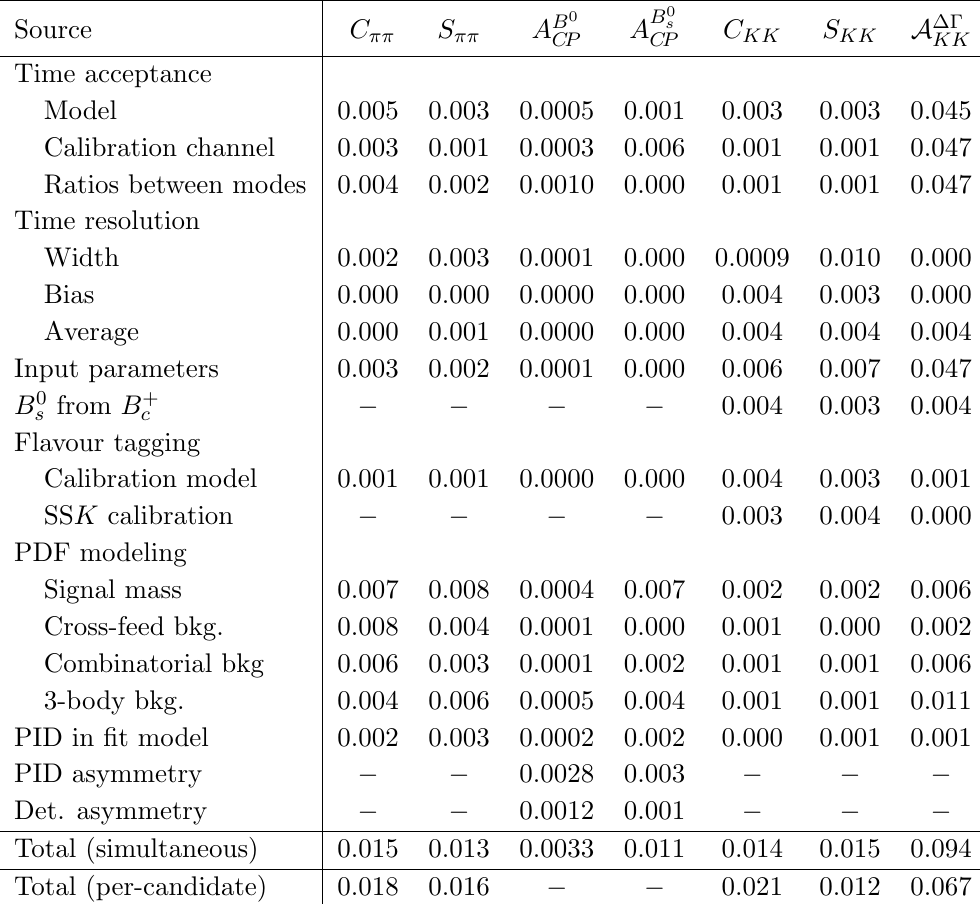
Table 2 . Systematic uncertainties on the CP -violating parameters. The values given for each individual contribution to the systematic uncertainty are those for the simultaneous method. The total systematic uncertainties are given both for the simultaneous and the per-candidate methods. The dash indicates that the uncertainty is not